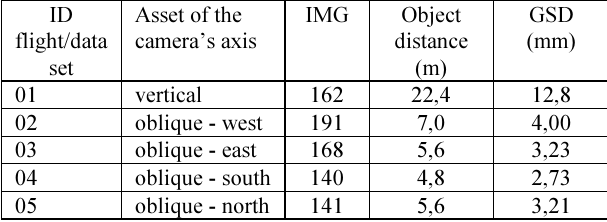
Table 1: flights/dataset performed, taken images, GSD and